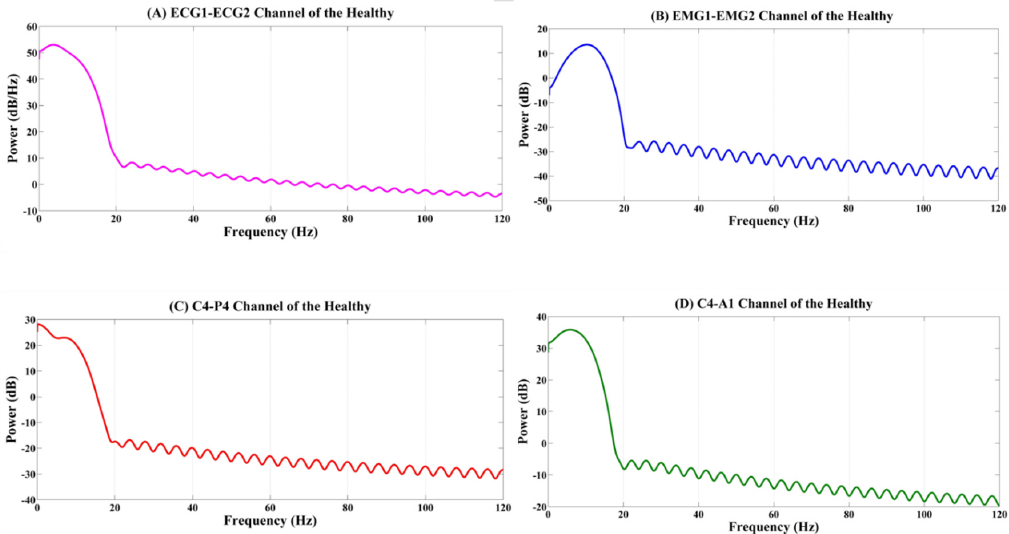
Figure 6. Power spectral analysis of the channels such as ( A ) the ECG1-ECG2 channel, ( B ) EMG1-EMG2 channel, ( C ) C4-P4 channel, and ( D ) C4-A1 channel of the healthy subjects.